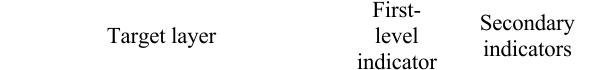
Table 1. Multi-indicator system of pathological weight loss effect of aerobic